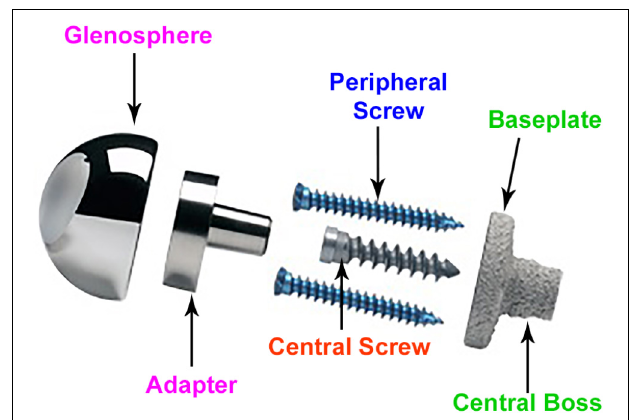
FIGURE 2 | Description of rTSA